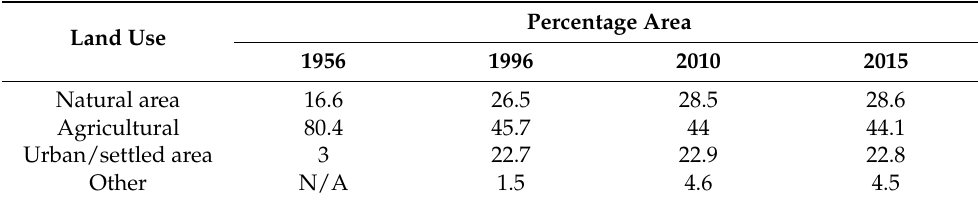
Table 6. Table showing the land cover percentage for the years 1956 (published data [24]), 1996 [24] (published data), 2010 (Landsat satellite data) and 2015 (Landsat satellite data) [31].